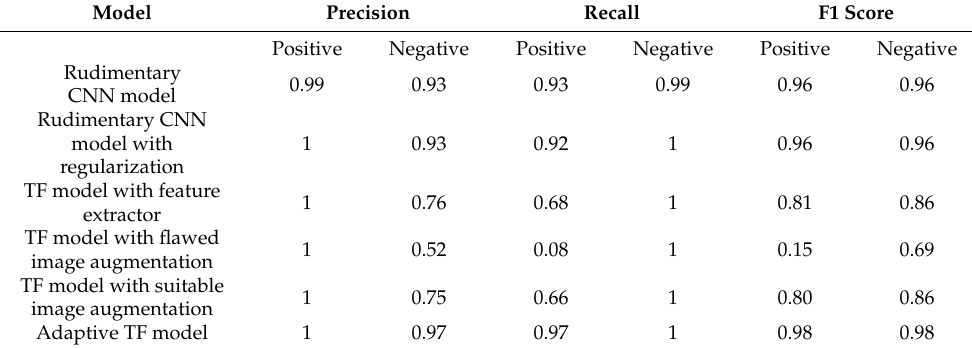
Table 3. Confusion